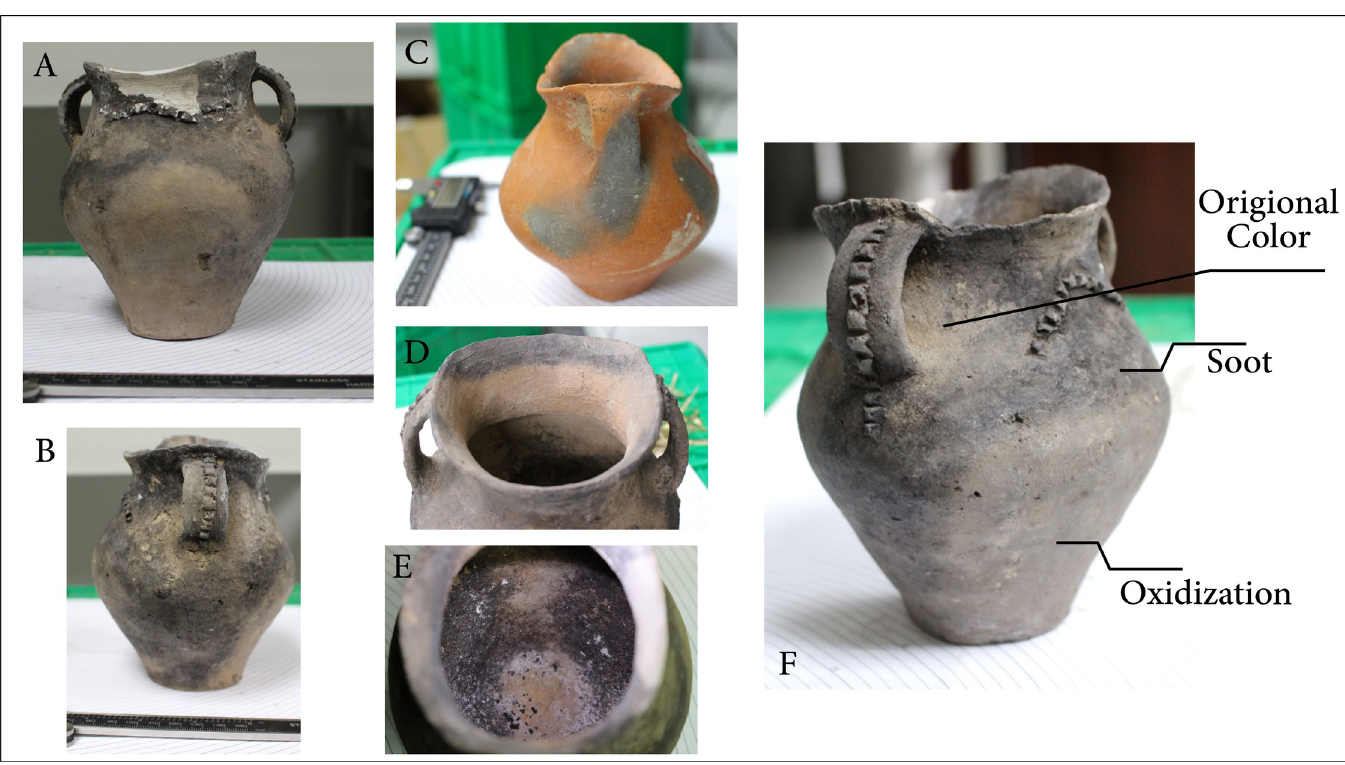
Fig 3. Observed use-wear patterns on Siwa ma’an cooking vessels. A. Frontal image of ma’an jar showing external soot pattern (base is about 4.5 cm across). B. Handle- sided view of ma’an jar showing external soot pattern. C. Changes in paste color resulting from fire clouding or other production processes. D. Internal carbonization on upper portion of lip. E. Internal carbonization on walls. F. Ma’an jar with use-wear pattern (soot and